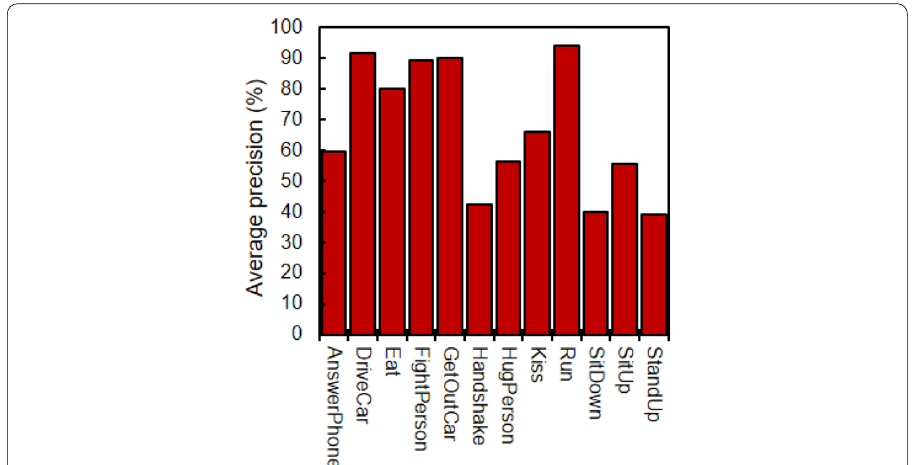
Fig. 12 The detailed accuracy by class for the Hollywood2